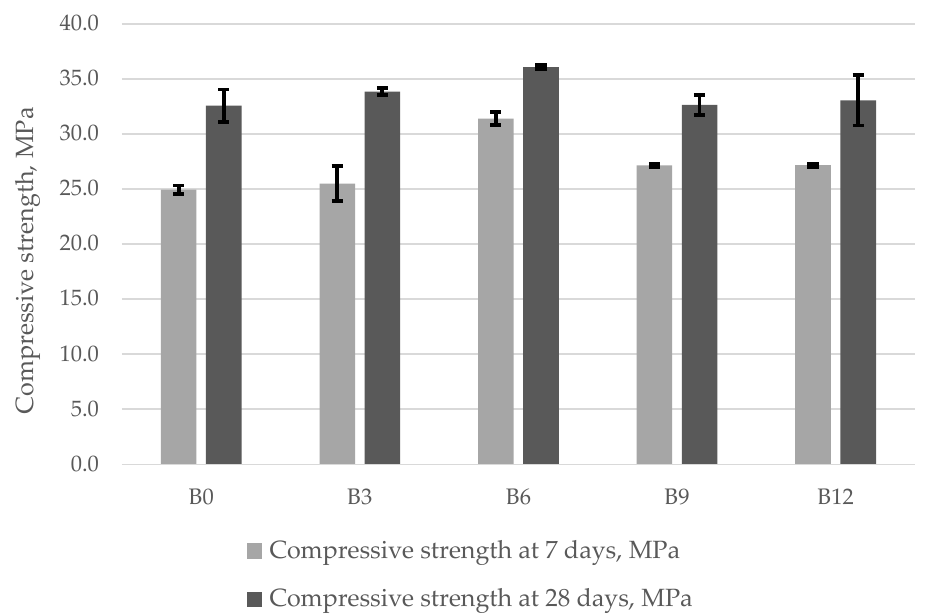
Figure 4. Average compressive strength values for concrete specimens containing ash.